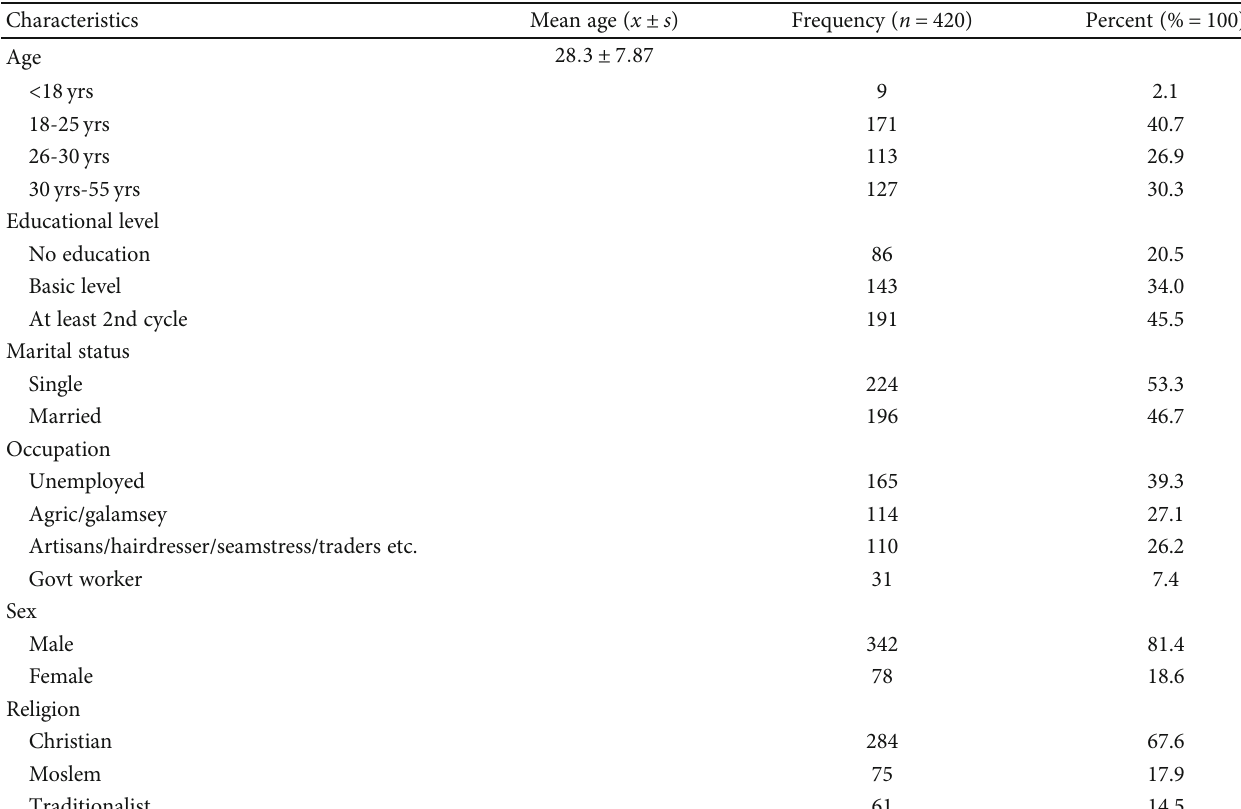
Table 1: Demographic